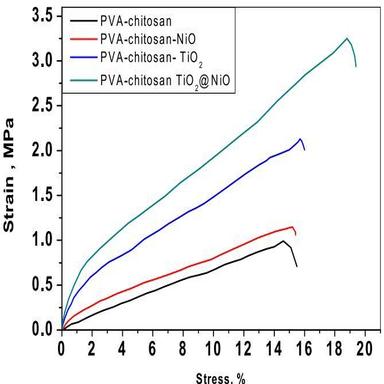
PVA-chitosan–TiO2, PVA-chitosan–NiO, and PVA-chitosan– TiO2@ NiO films.